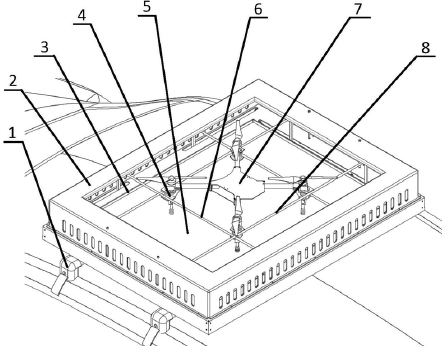
Figure 10. Unmanned aerial vehicle landing platform mounted on a mobile vehicle [44] with parallel pushers for UAV positioning by Beijing Institute of Technology. 4, UAV fixing element; 5, landing site; 6, short clamping bar; 7, UAV; 8, long clamping bar.